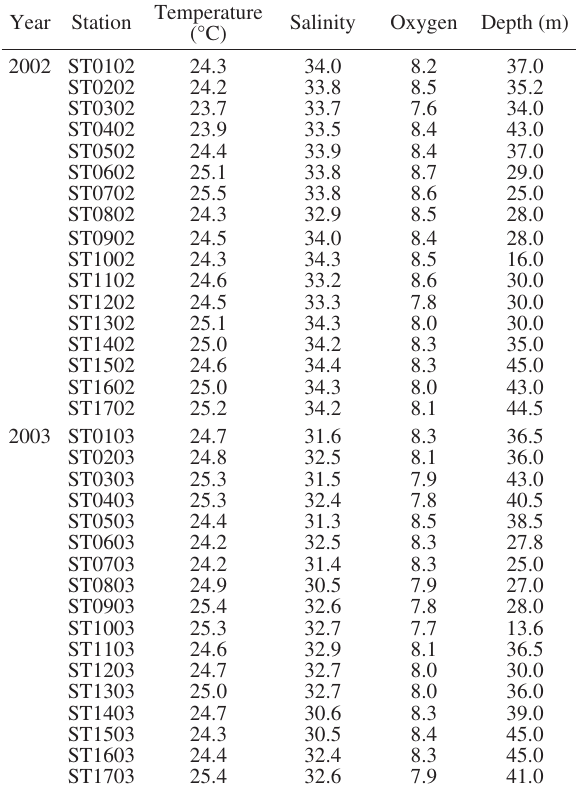
Table 2. – Sea surface physical-chemical parameters and maximum depth of the 17 stations in Kavala Gulf. Stations’ abbreviations are consistent with the formula ST (number of station) (sampling year; 02 for 2002 and 03 for